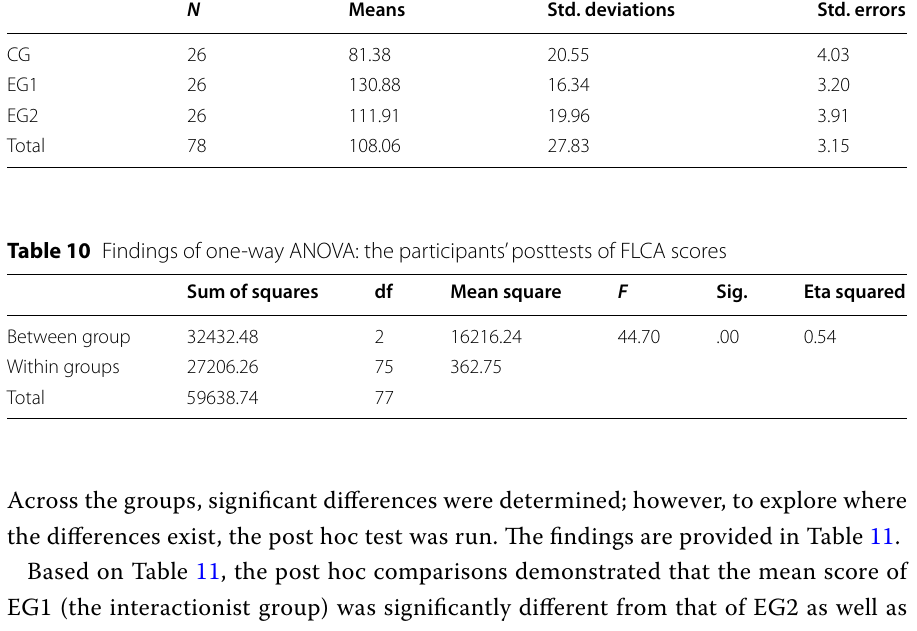
Table 11 Results of the Scheffe post-hoc test: the participants’ post-test of FLCA scores (I) groups (J) groups Mean CG